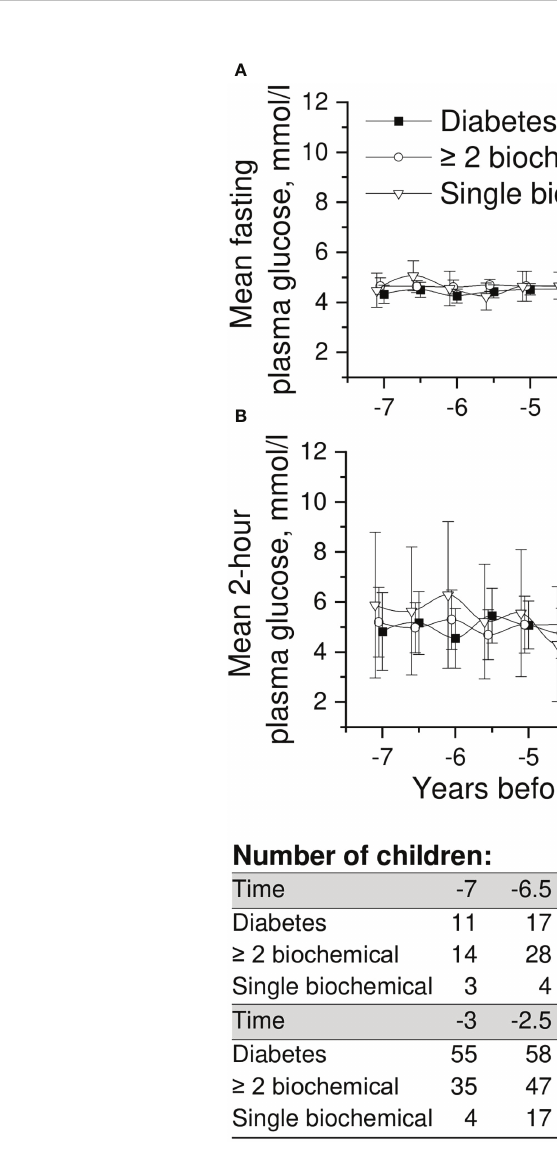
FIGURE 3 Adjusted mean plasma glucose levels in OGTT [ (A) =fasting and (B) =2-h plasma glucose], during the follow-up in children in three risk groups (OGTTs were not performed in the ICA only and transient autoantibody positivity groups). The last points are diagnosis of type 1 diabetes (progressors, black squares) or the last follow-up visit by August 31, 2014. Whiskers show 95% con fi dence intervals of the adjusted mean in the linear mixed model. No signi fi cant differences in the early plasma glucose values were observed between the groups. OGTT values started to rise toward diagnosis in the